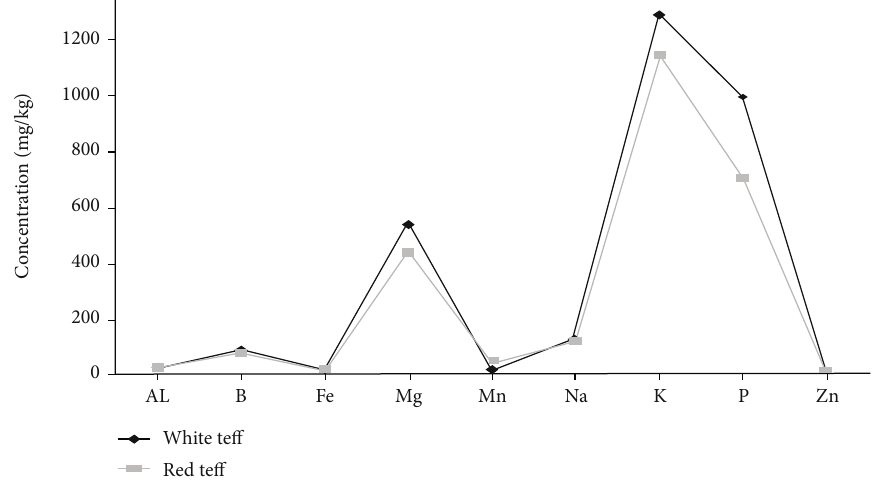
Figure 1: Trace element content of white and red te ff grain